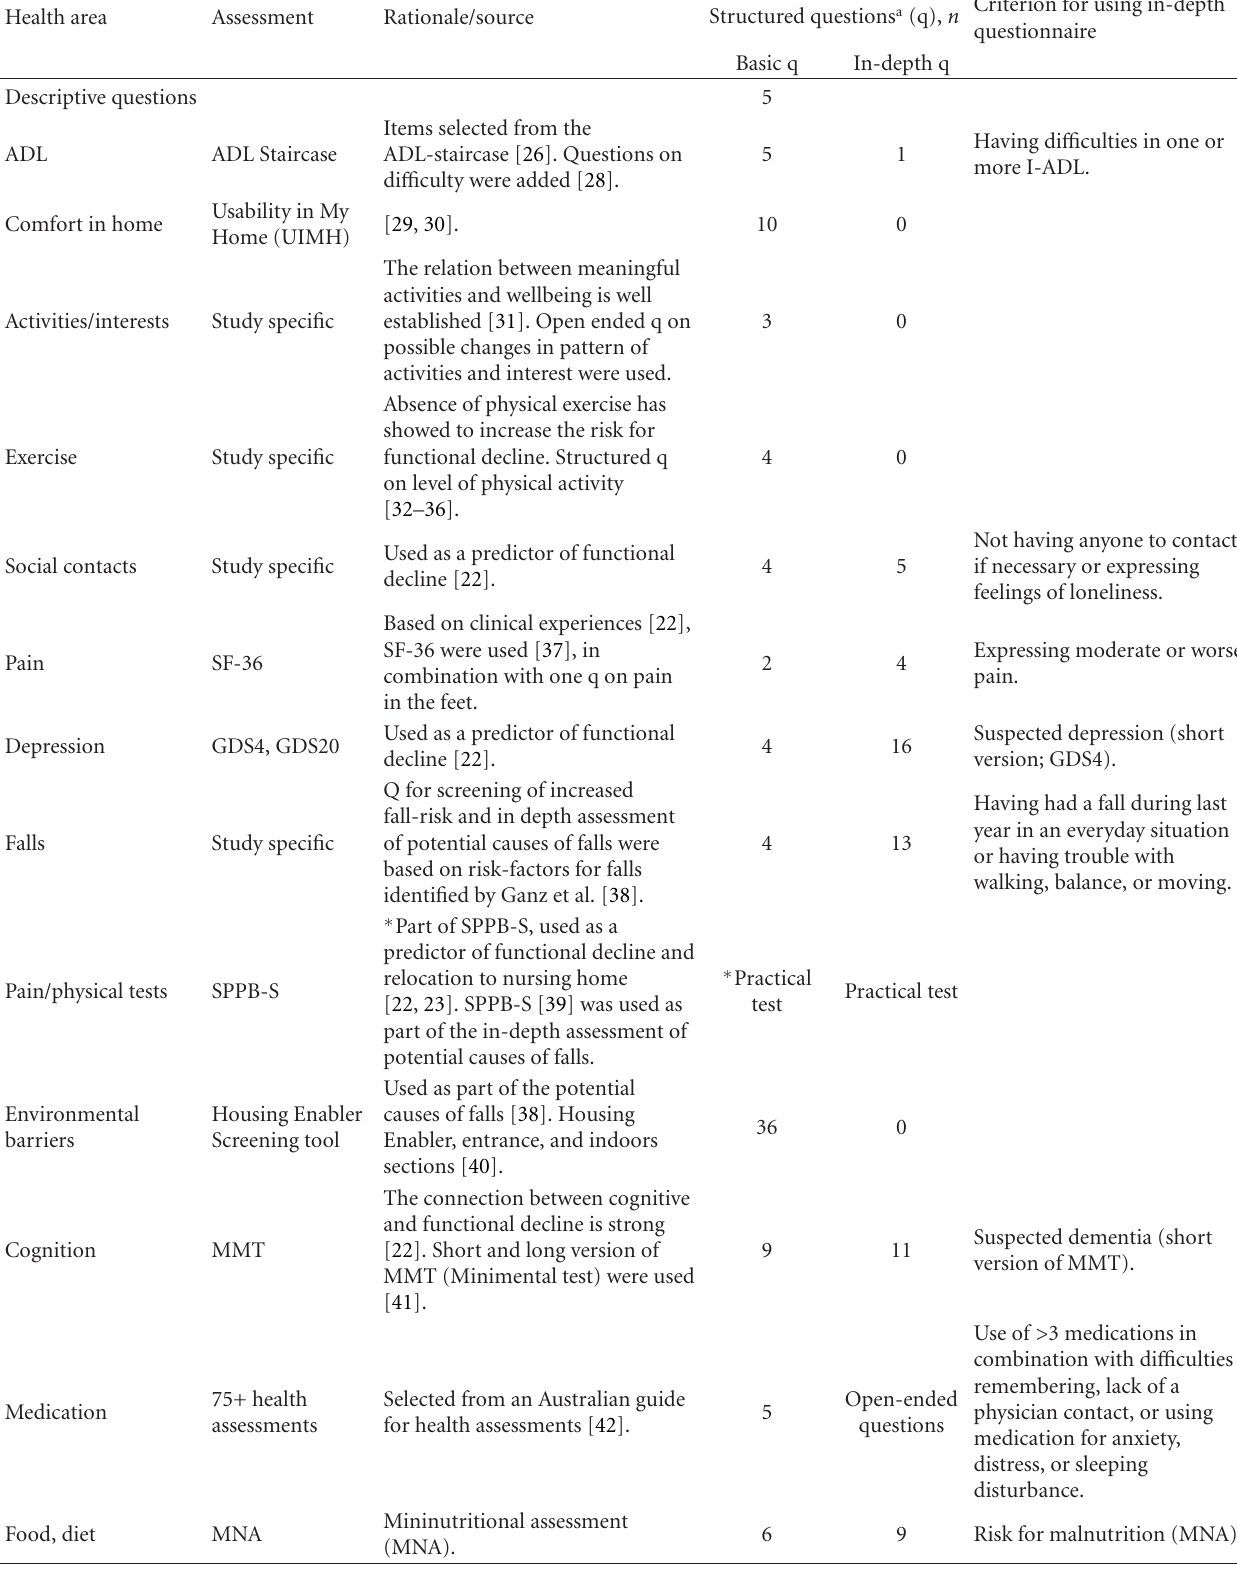
Table 2: Contents in PHV protocol administrated in the pilot